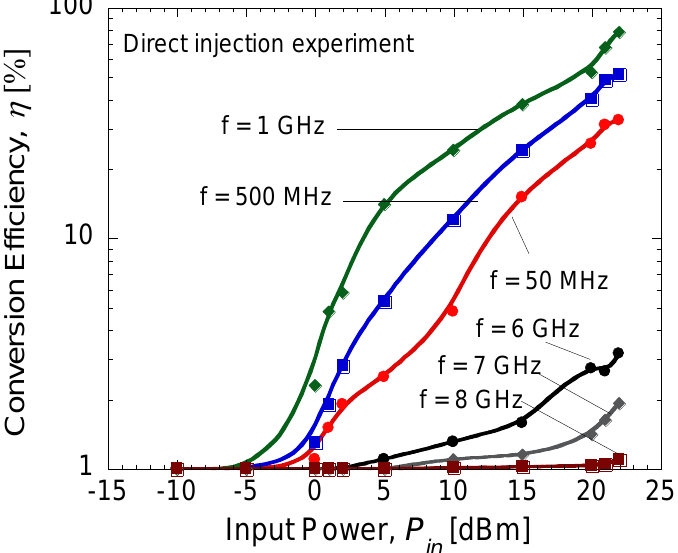
Figure 7. Conversion efficiency as a function of input power at several